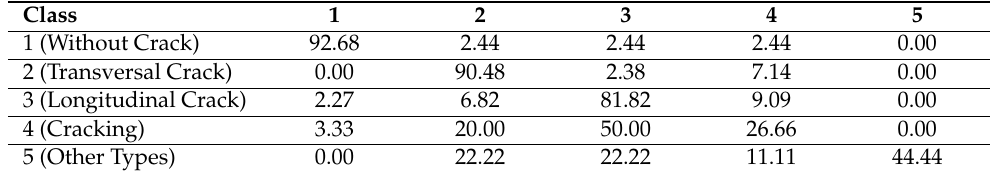
Table 6. Confusion matrix of the classification of crack images.